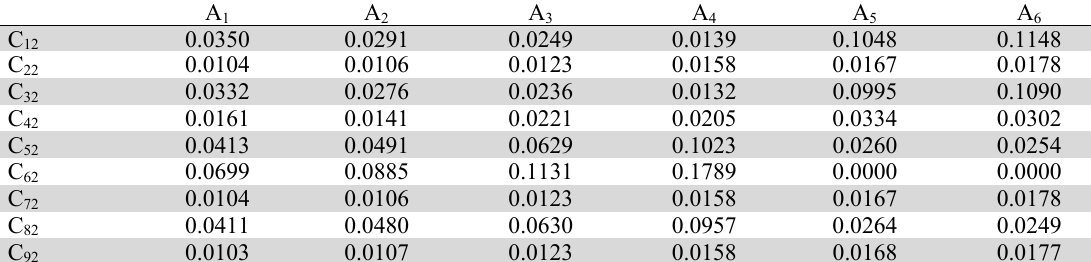
Weighted normalised economic criteria decision-matrix